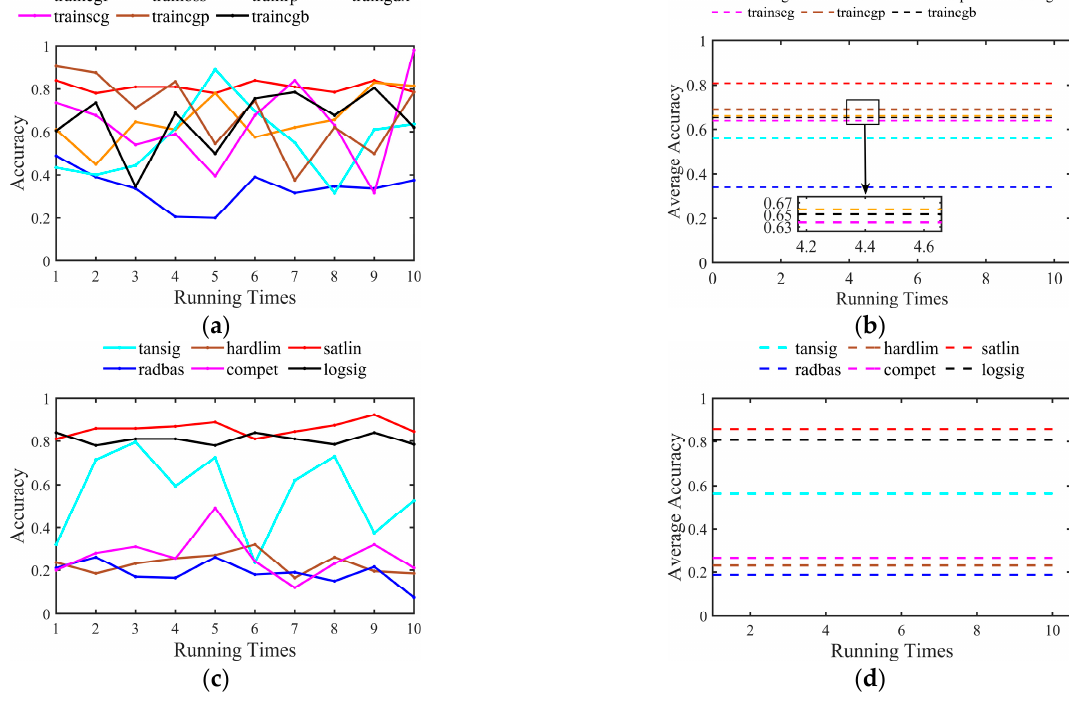
Figure 7. Comparison of the accuracy with different ( a , b ) training functions and ( c , d ) activation functions.